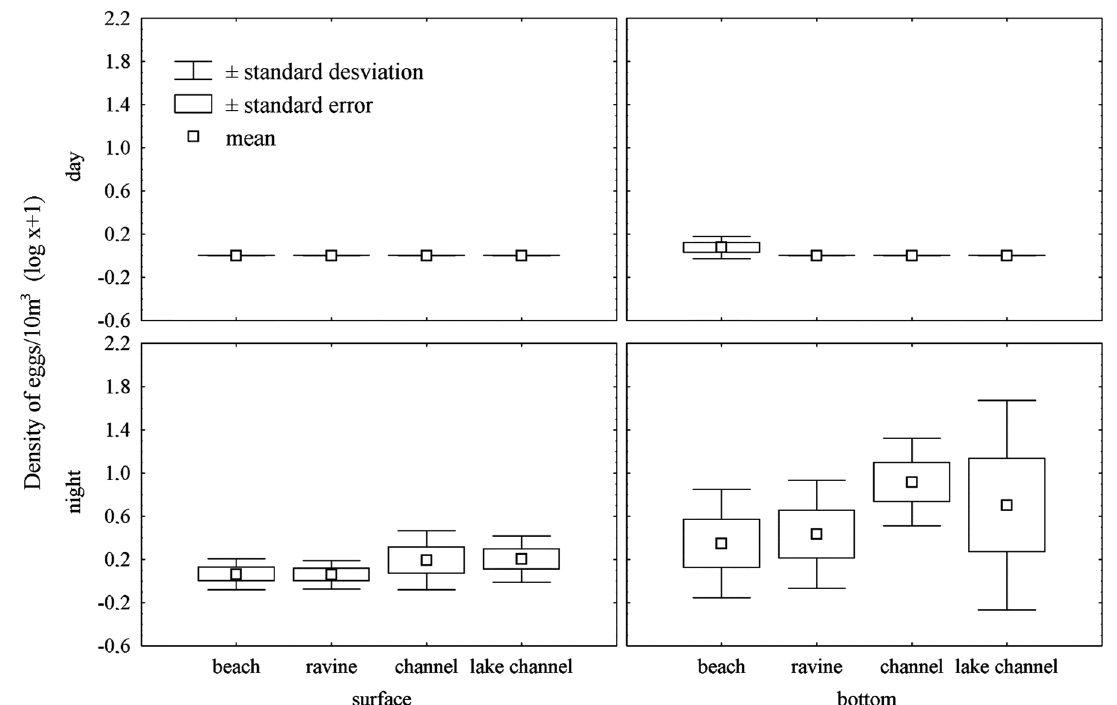
Fig. 2. Abundance of eggs in different microhabitats in the surface and bottom in the Anavilhanas Ecological